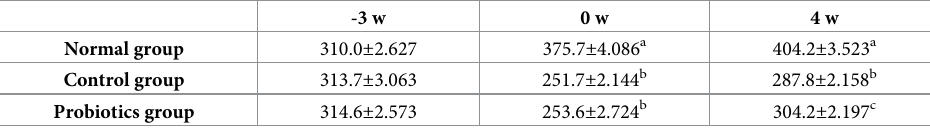
Table 2. The effect of probiotics treatment on body weight (g) in adenine-induced CKD rats.